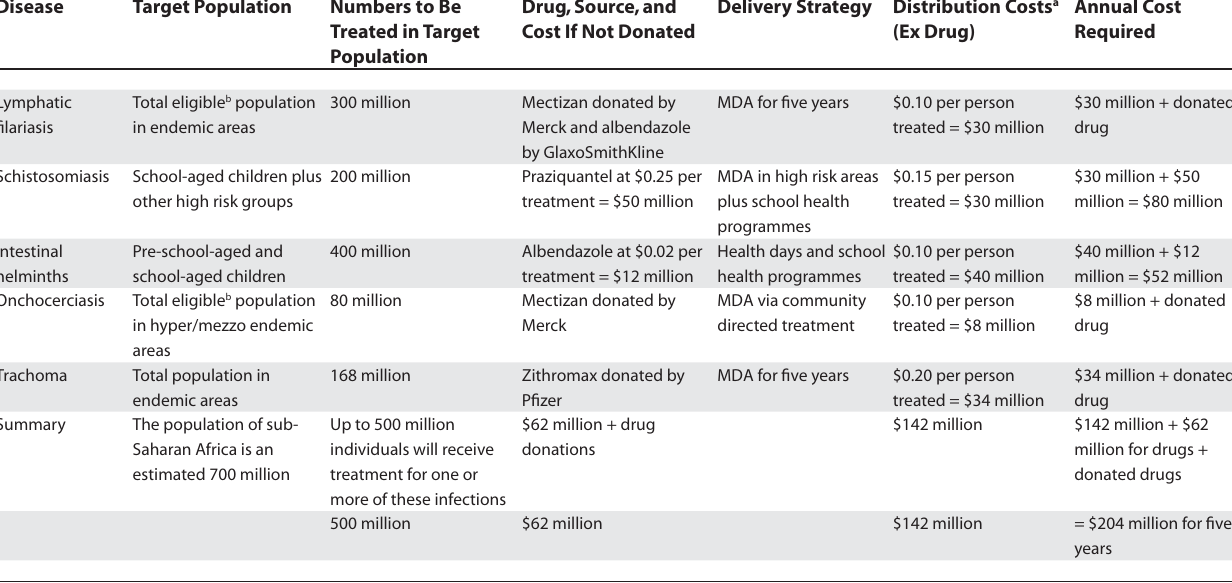
Table modifi ed from [23], with permission from Elsevier. Assumptions for Table 3 are as follows. (1) An estimated 500 million people will be reached and treated as appropriate for fi ve diseases at a total cost of $204 million. (2) The per-person cost will therefore be approximately US$0.40 and by integrating treatments there could be substantial savings on delivery costs. (3) Cost saving by combining delivery could reach an estimated 25%. (4) After fi ve years’ intervention, it is expected that mass chemotherapy of some of these infections will no longer be necessary, but monitoring will be recommended on a longer-term basis to confi rm this hypothesis. (5) Delivery could be combined with vaccinations (polio, measles-mumps-rubella, measles) and vitamin A capsules. a The distribution costs are estimates derived from experience with vertical programmes. Schistosomiasis is very focal and therefore requires more extensive mapping data to determine the target population. Trachoma delivery costs include some allowance for surgical intervention in extreme cases. b The following are not eligible: children less than 90 cm in height, severely ill patients, and pregnant women. MDA, mass drug administration. DOI: